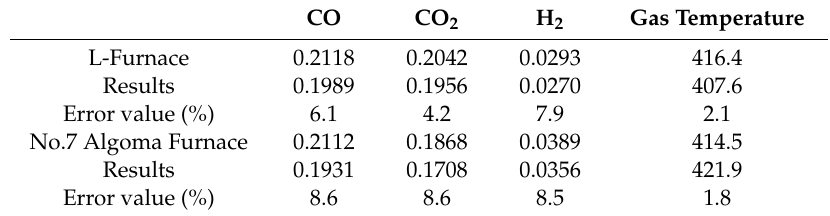
Table 6. Comparisons between the calculated and measured parameters of two reference